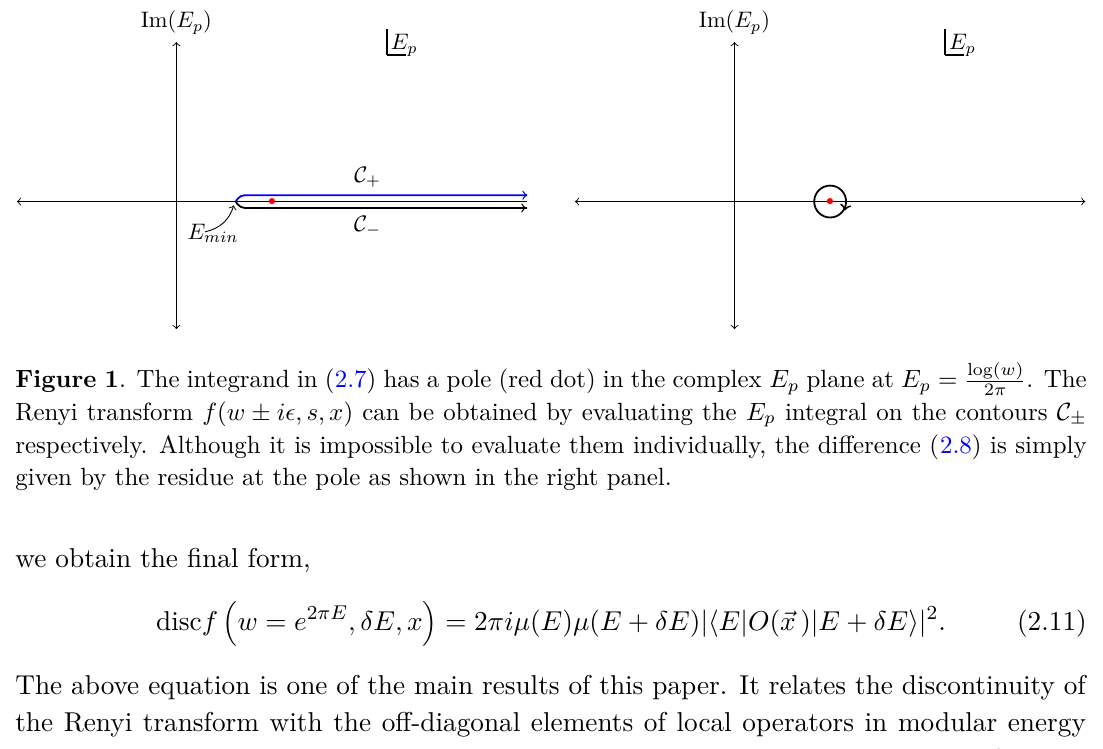
Figure 1 . The integrand in (2.7) has a pole (red dot) in the complex E p plane at E p = log( w ) Renyi transform f ( w ± i(cid:15), s, x ) can be obtained by evaluating the E p integral on the contours C ± respectively. Although it is impossible to evaluate them individually, the difference (2.8) is simply given by the residue at the pole as shown in the right